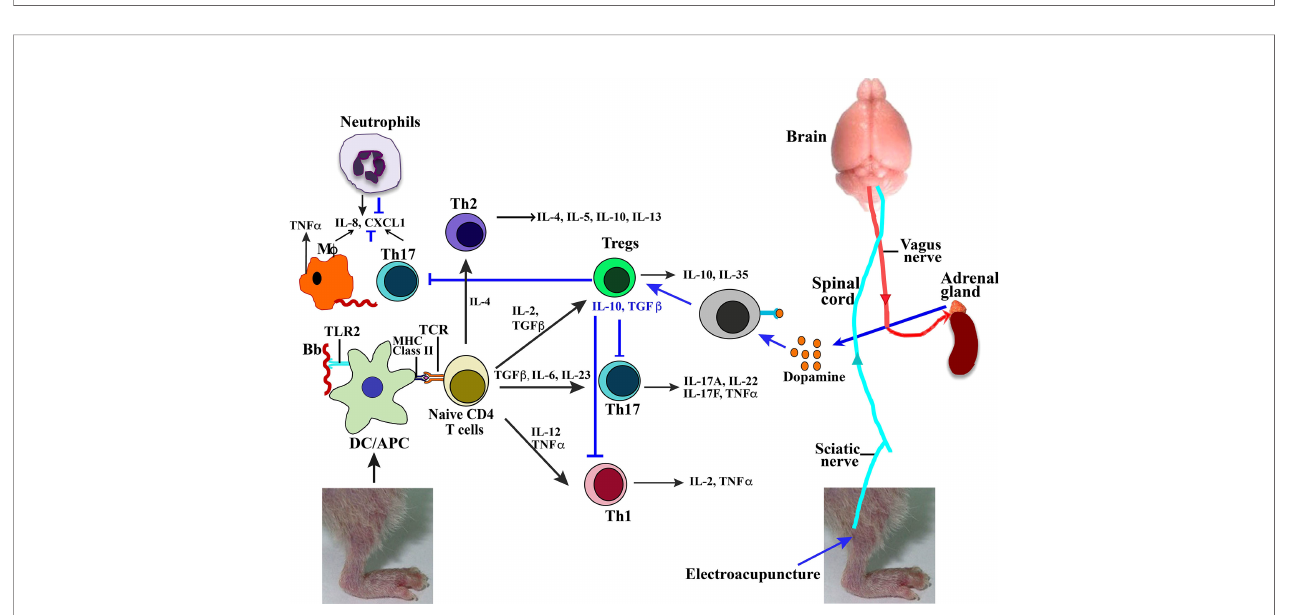
FIGURE 6 | Comparative analysis of mock- and EA-treated female immunocompetent and SCID C3H female mouse joint sections to determine in fl ammation. (A – D) Leukocyte in fi ltration was reduced in EA-treated mice (B and D versus A and C) irrespective of immunological genotype of mice. Leukocyte in fi ltration (arrows) showed association with joint swelling (not shown) and diminished in the joints of EA- compared to mock-treated mice. Cartilage damage and increase in synovial space resolved in these young mice at this stage. (E – H) Neutrophils (red, anti-Ly6G rabbit antibodies followed by anti-rabbit TRITC-conjugated antibodies) were the predominant leukocytes in the joints of all infected mice, and their levels were reduced in EA-treated mice. Only a few macrophages in panels E – H (purple, anti-F4/80-APC antibodies, arrows) and T cells in panels E and F (green, anti-CD3-Alexa Fluor 488 antibodies, arrowheads) were observed in tibiotarsus joints. (I – L) Higher magni fi cation of sections shown in panels E – H . Green cells in SCID mice joints (G, H, K, L) are likely NKT cells. EA, electroacupuncture; SCID, severe combined immunode fi